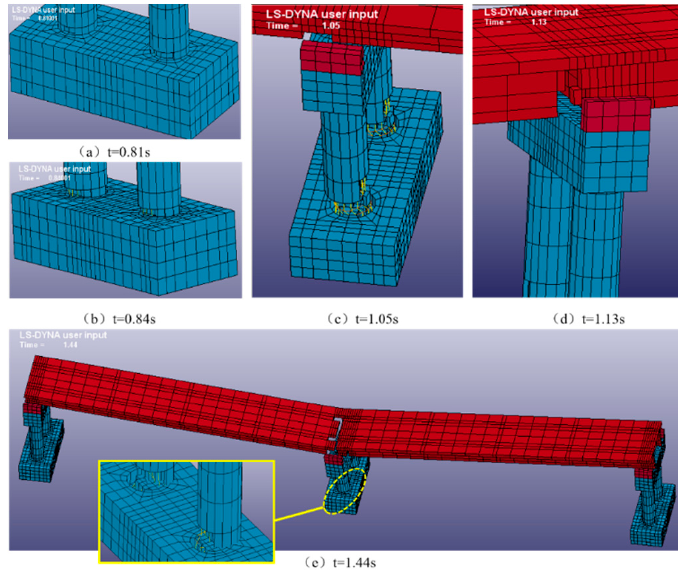
Figure 9. Longitudinal collapse mode of bridge specimen under the El Centro wave.